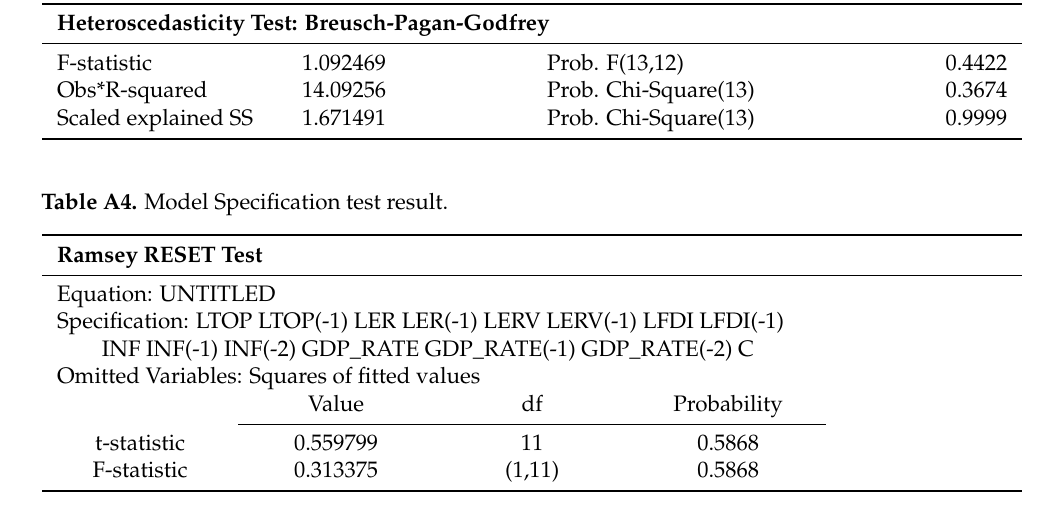
Table A3. Heteroscedasticity test result.